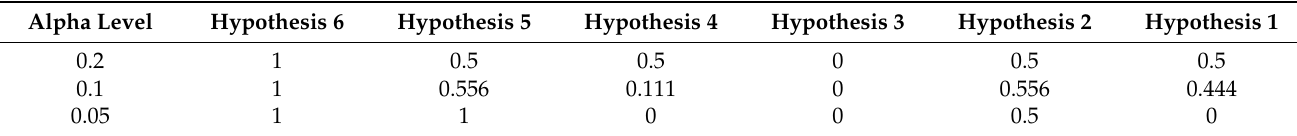
Table 3. Proportion of all hypotheses including each of the six individual hypotheses significant at three alpha levels (0.05, 0.1, and 0.2) for the spatial niche partitioning analysis.